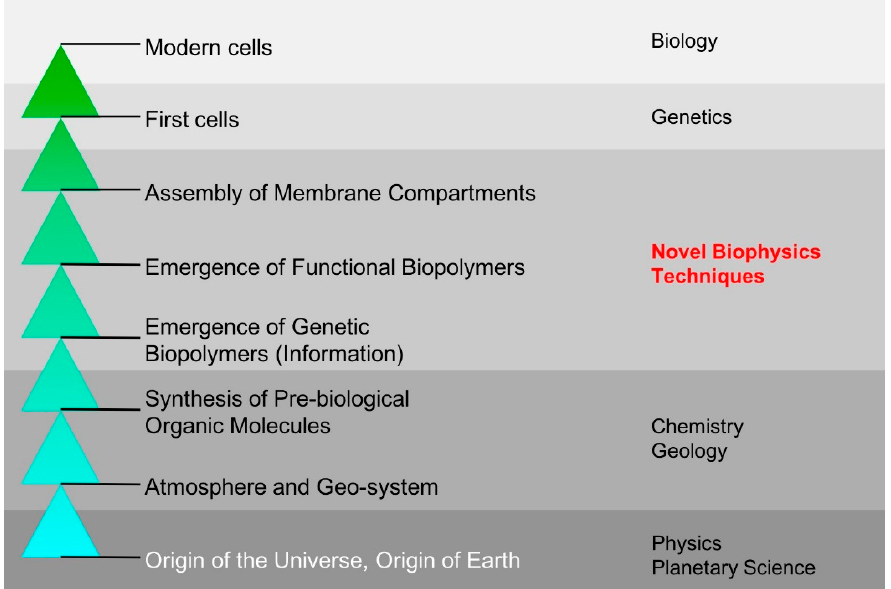
Figure 1. A chronological view of origins of life research (from bottom to top), starting from the origin of Earth and ending at modern cells. Specifically, biophysicists in Japan have been contributing